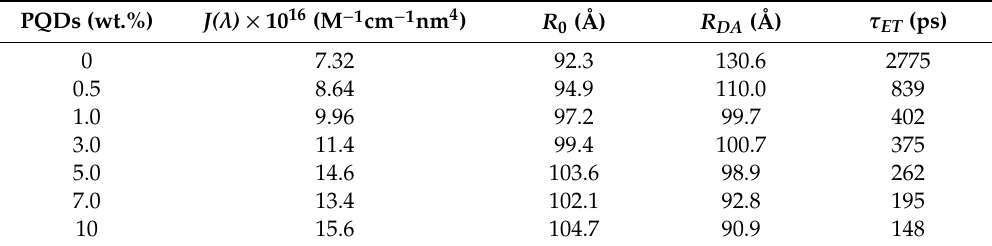
Figure 7. Stern–Volmer plot for the emission quenching of PFO with various PQD contents. Table 2. Parameters of energy transfer from PFO to the MEH-PPV hybrid thin films with various PQD contents.